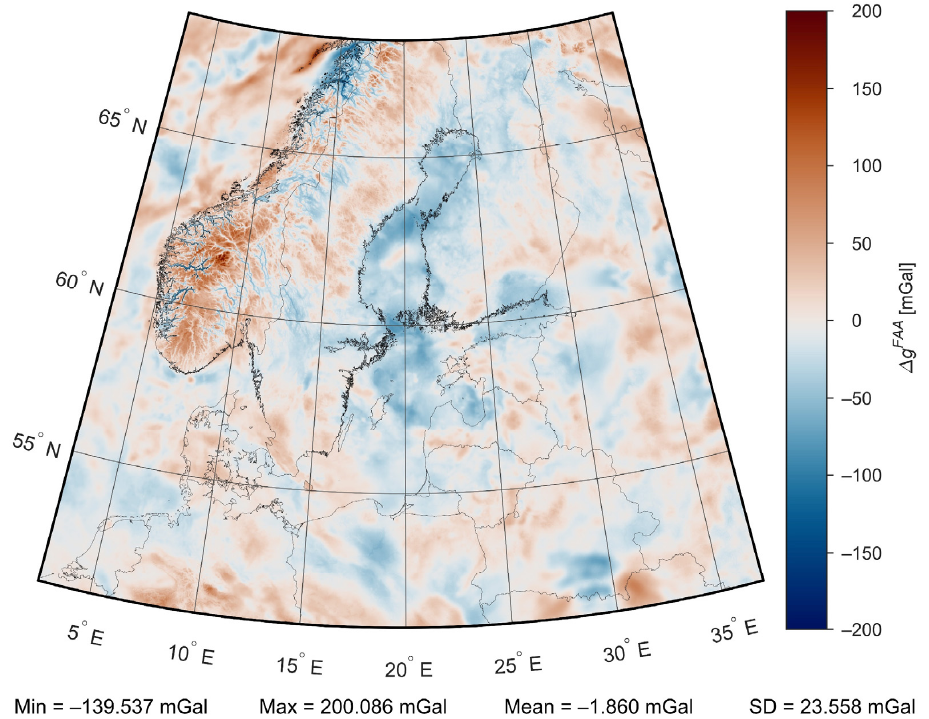
Figure 10. Gridded surface free-air anomalies computed by also considering bathymetry information.